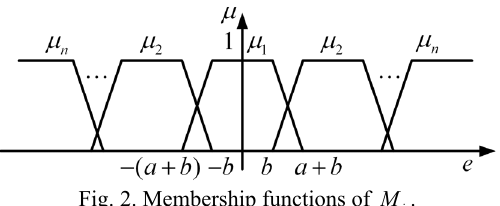
Fig. 2. Membership functions